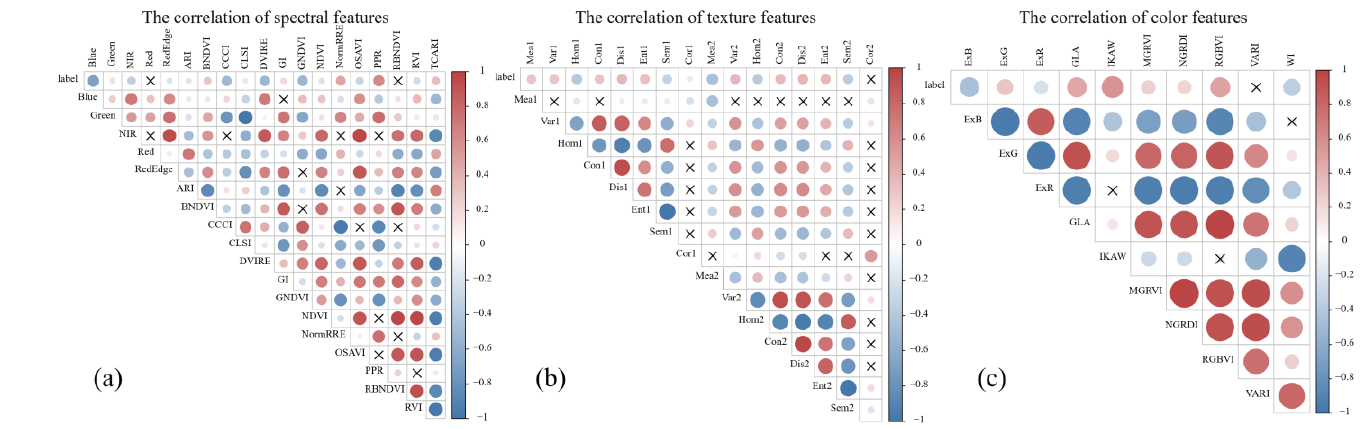
Figure 5. Correlation between VIs, TFs, CFs, and PM. ( a ) The correlation of spectral features, ( b ) The correlation of texture features, ( c ) The correlation of color features. Table 4. Specific values and significance levels of the correlation coefficients of VIs, TFs, and CFs. Spectral Parameter